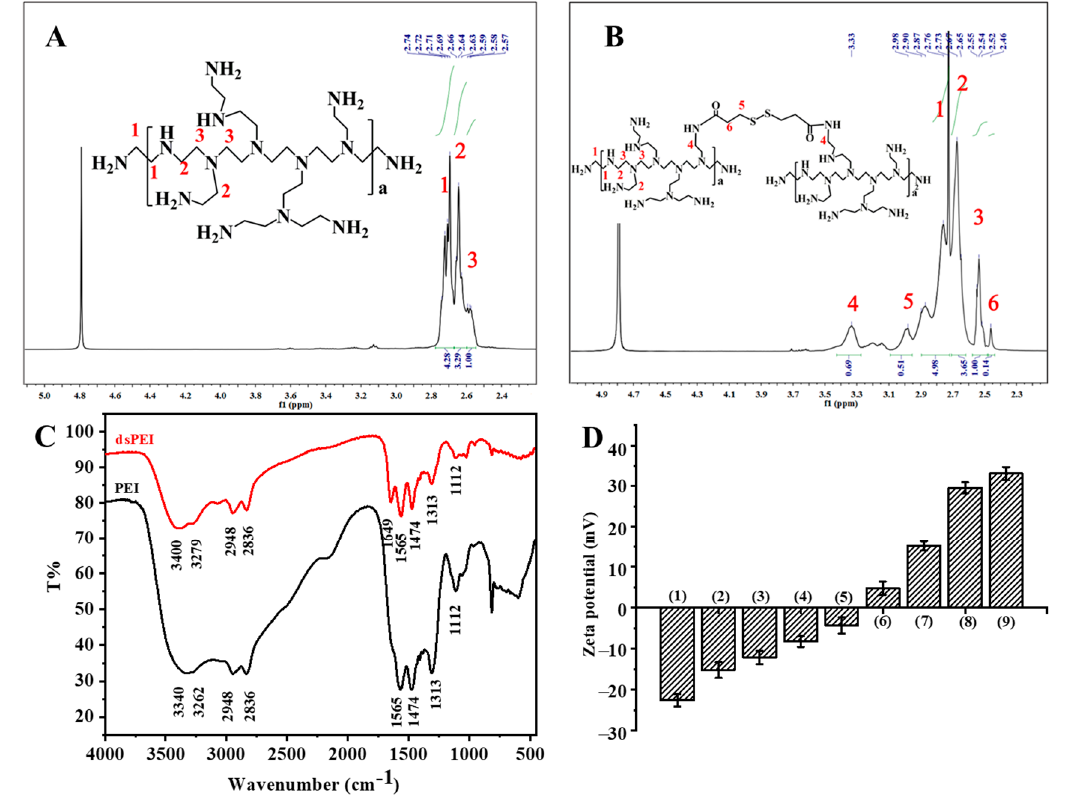
Figure 2. ( A ) 1 H NMR spacetra of PEI. ( B ) 1 H NMR spacetra of dsPEI. ( C ) FT-IR spectra of PEI and